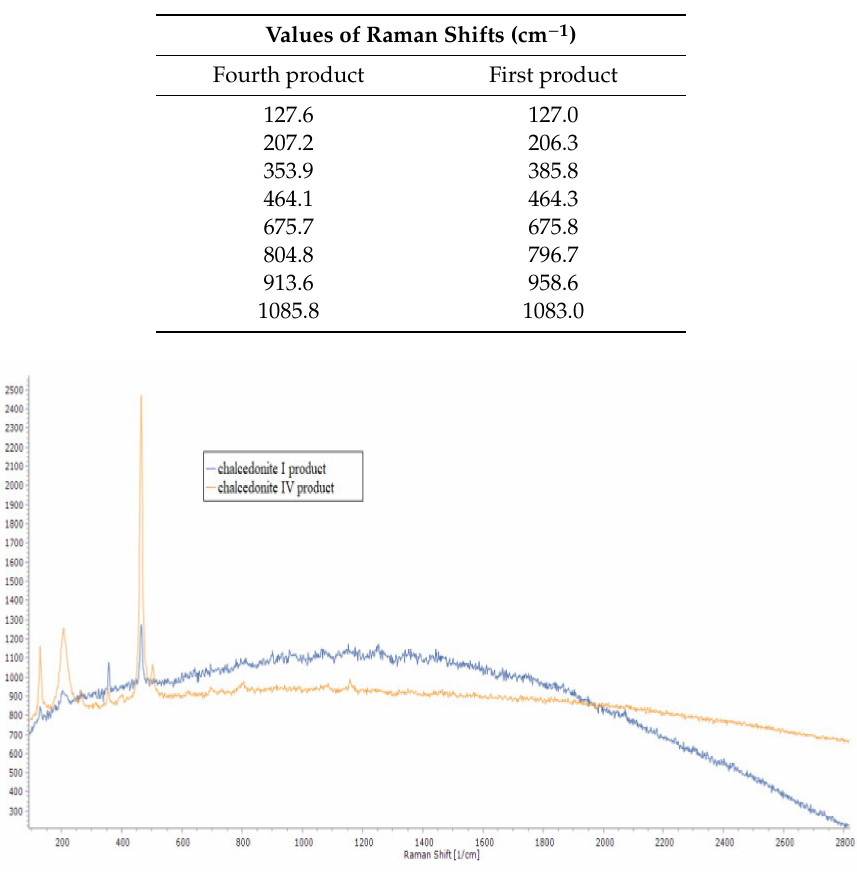
Table 4. Raman shifts obtained as a result of irradiation of the chalcedonite samples.